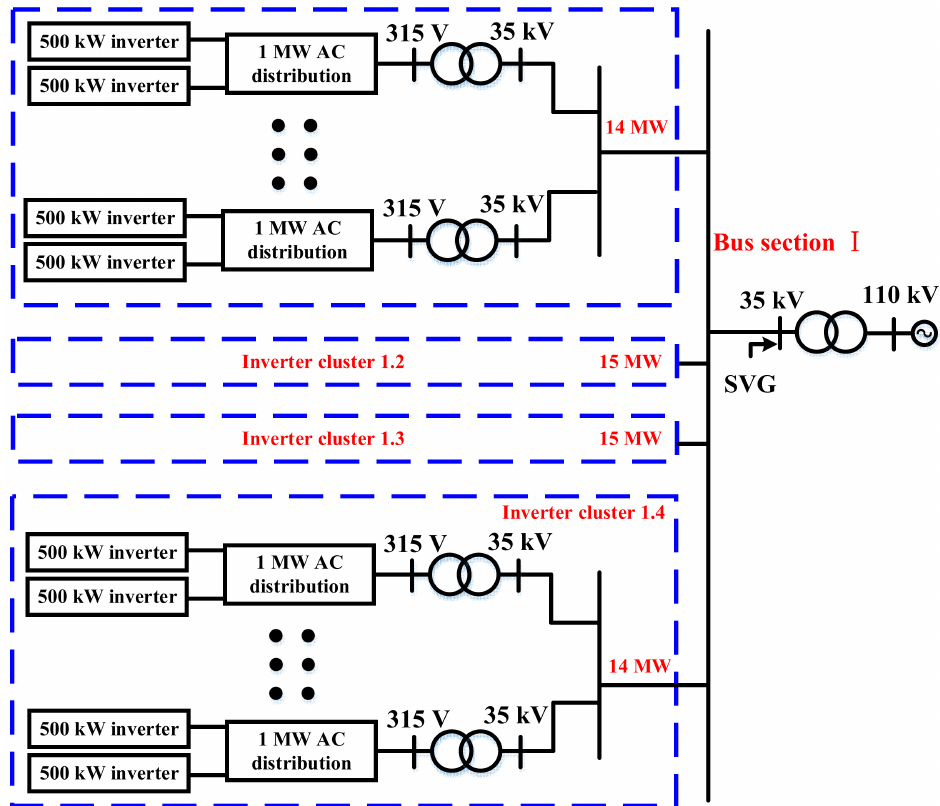
Figure 2. Structural diagram of bus section I of the investigated 200 MW photovoltaic station.